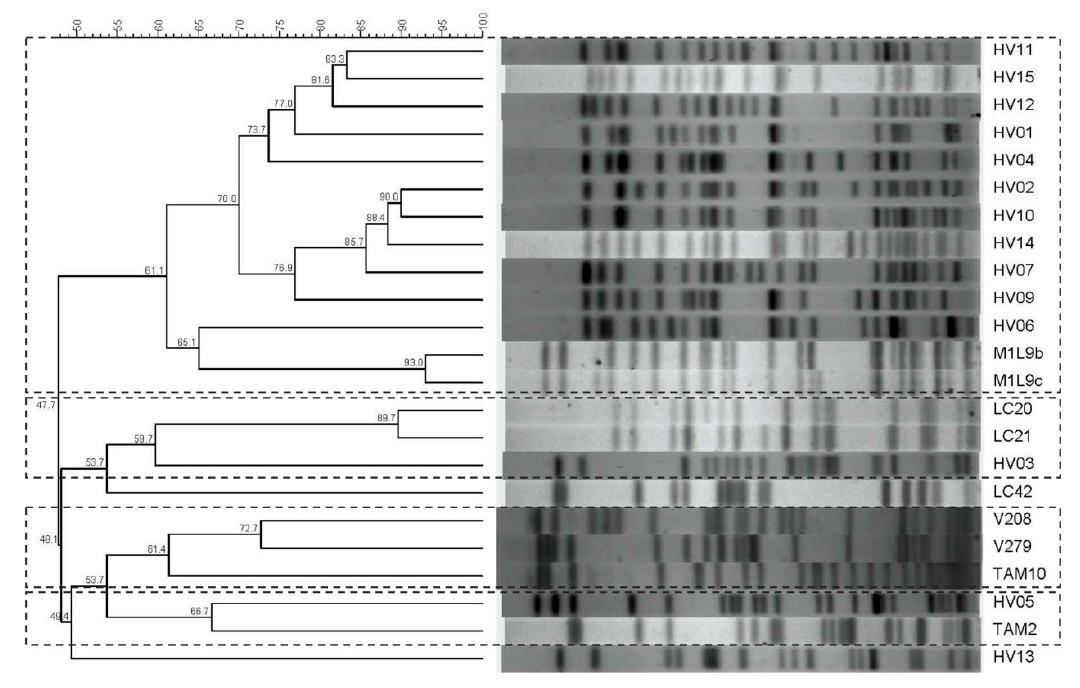
Figure 1. PFGE profiles and cluster analysis of 23 human and food isolates. Main groups are marked by broken lines.